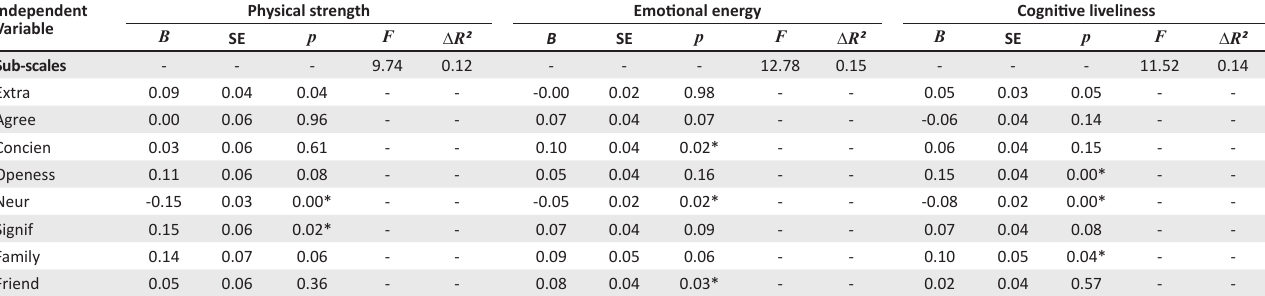
TABLE 3: Multiple regression analysis with dimensions of personality and perceived social support as independent variables and physical strength, emotional energy and cognitive liveliness as dependent variables. Independent Physical strength Emotional energy Cognitive Variable